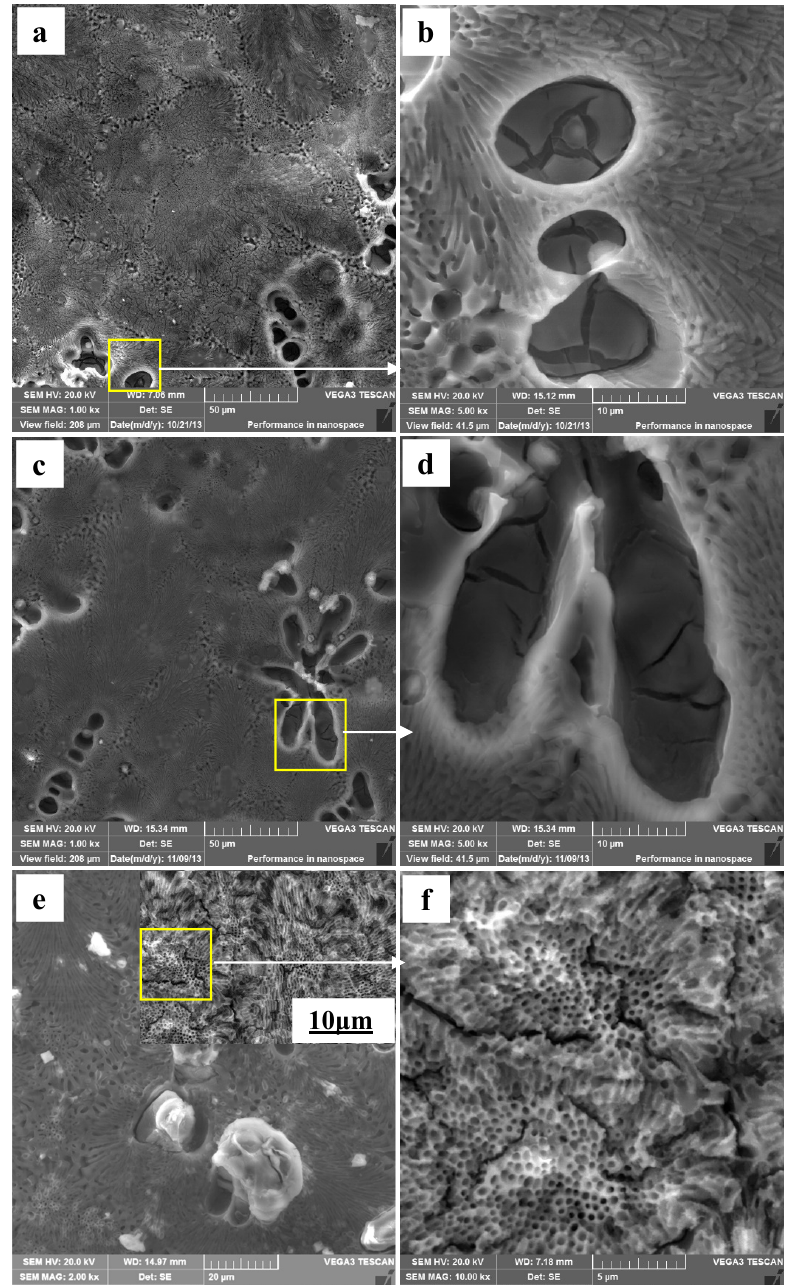
Figure 6. The corroded Mg–Al alloyspecimen’s corrosion morphologies gained from H 2 SO 4 solution for different immersion times: ( a , b ) 30 min; ( c , d ) 60 min; ( e , f ) 90 min.